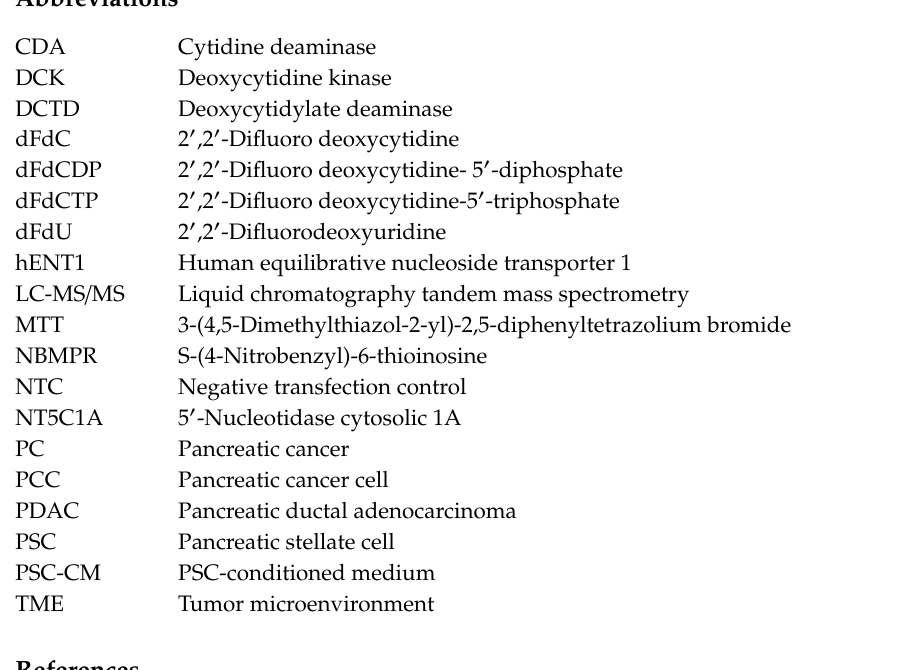
Table S2: siRNA details, Table S3: Gemcitabine IC50 values and its metabolites levels or protein expression of metabolizing enzymes in pancreatic cancer cells, Figure S1: Senescence-associated β -galactosidase staining, Figure S2: Pharmacokinetic profile of gemcitabine and its metabolites, Figure S3: Expression of key regulators of gemcitabine metabolism was not influenced by gemcitabine exposure, Figure S4: Transfection e ffi ciency, Figure S5: Uncropped western blot